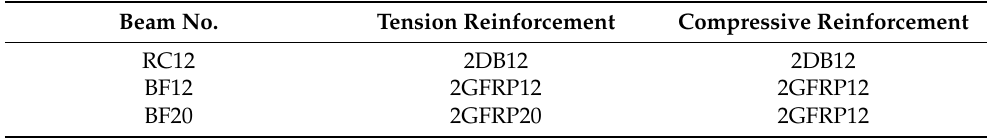
Table 1. Details of test